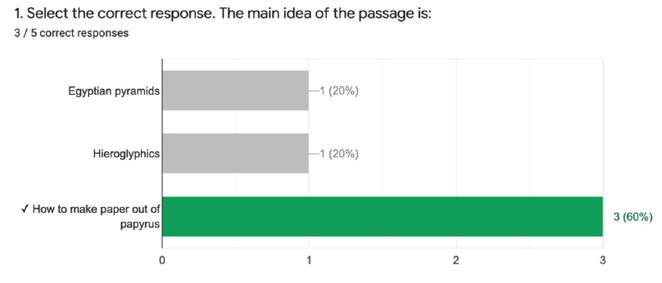
Figure 6. Performance example.